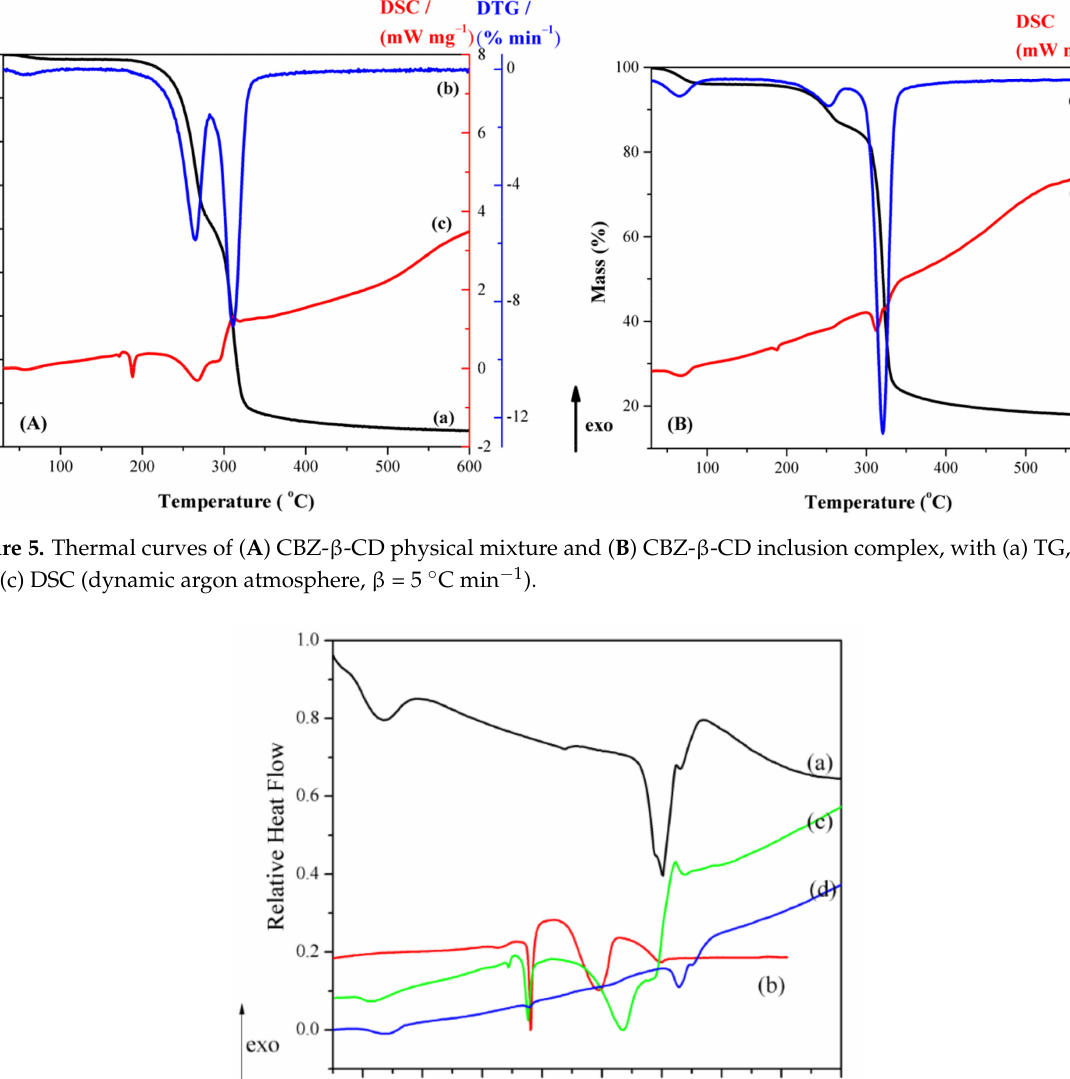
“relative heat flow”, RHF, was calculated as described in equation (2) and represented in Figure 6: HF ( T ) − HF min RHF = where RHF is the relative heat flow, T is the temperature of the thermal process, HF ( T ) is the observed heat flow (the DSC output), HF min is the minimum heat flow signal and HF max is the maximum heat flow signal [49].